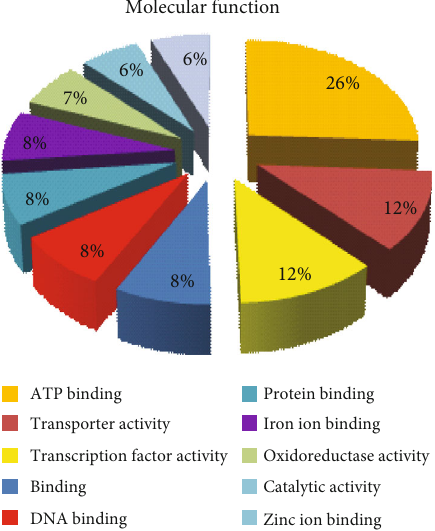
Figure 5: Gene Ontology (GO) distributions for reniform nematode genomic sequences as determined by Blast2GO and grouped by molecular function for the SIGMA